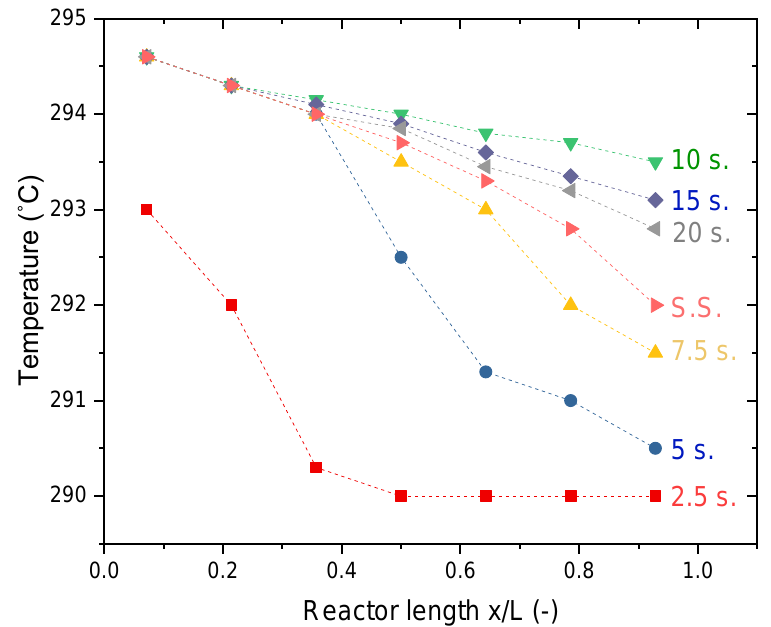
Figure 12. Evolution of the surface temperature over time upon feed of H 2 and CO 2 . Experimental conditions: total gas flow: 20 mL/min, H 2 :CO 2 = 4:1, P = 1 bar, baseline temperature = 290 °C. (S.S. = Steady State).